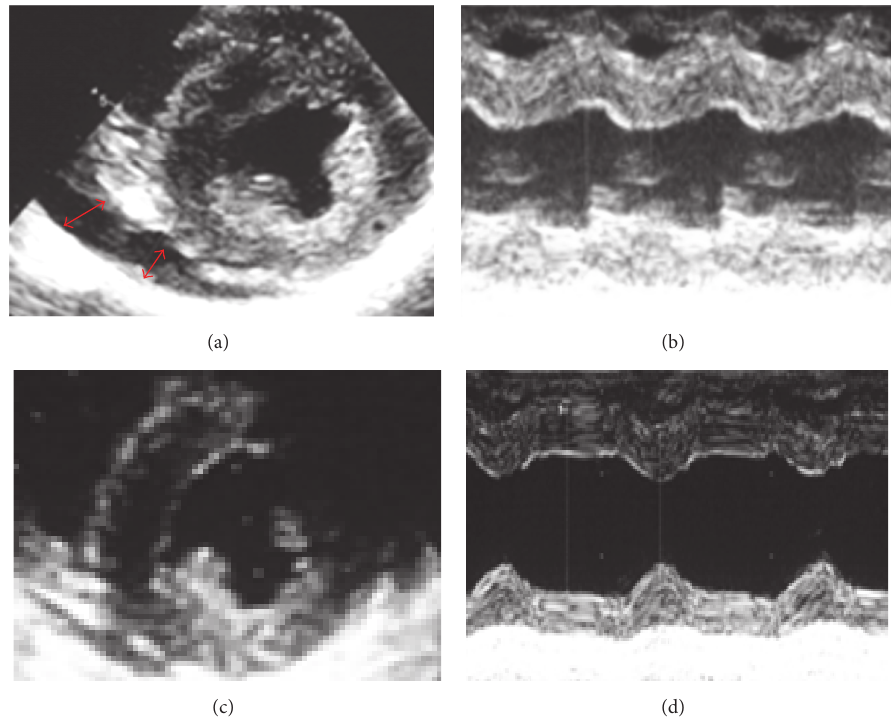
Figure 6: (a, b) Parasternal echocardiography at the onset of heart failure. (a) Short axis view showing pericardiac effusion (red arrow) and all-round ventricular hypertrophy. (b) Motion (M) mode through the left ventricle. The LVDd was 35 mm, left ventricular posterior wall systole (LVDs) 27.6mm, LVPWD 12.6 mm (196% of normal), and interventricular septal end diastole (IVSd) 13.3 mm (211% of normal). Also, the calculated LVEF was 55%. These findings suggest that diastolic dysfunction due to biventricular hypertrophy resulted in heart failure. (c, d) Parasternal echocardiography 7 days after the initiation of steroid pulse therapy. The LVDd was 40mm, left ventricular posterior wall systole (LVDs) 23 mm, LVPWD 8.7 mm (133% of normal), and interventricular septal end diastole (IVSd) 10mm (158% of normal). Also, the calculated LVEF was 80%. Biventricular hypertrophy was improving although still residual, and cardiac contractility was significantly